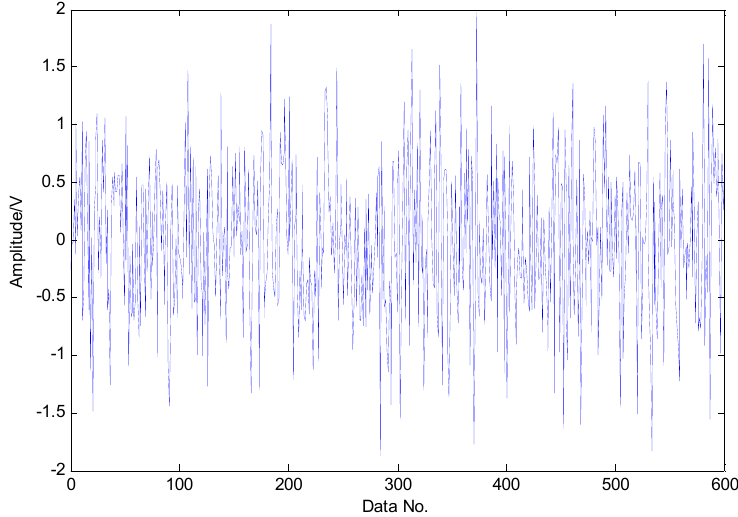
Figure 24. Random sampling of transient impact component through Gaussian random matrix.